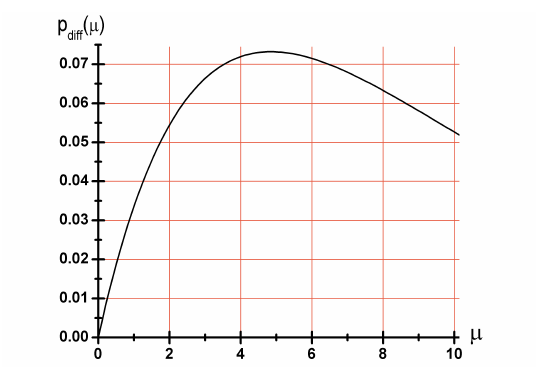
Figure 4. The difference between an honest Bob’s probability of obtaining a conclusive bit and half of a malicious Bob’s probability of obtaining a conclusive bit changing with µ .